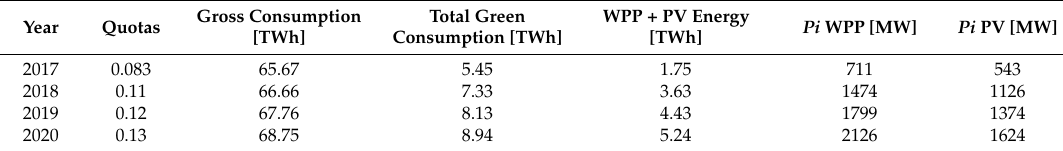
Table 8. Simulation of best